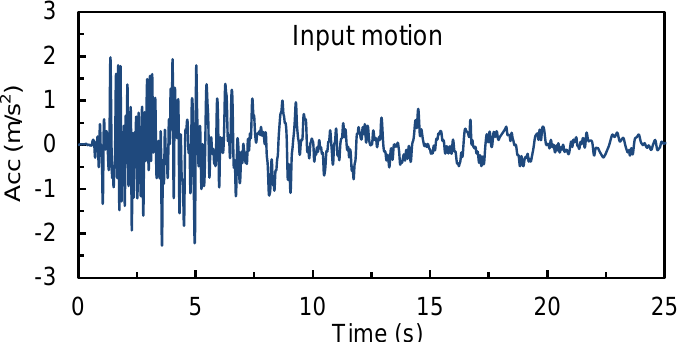
Figure 4. The acceleration time history of input motion.